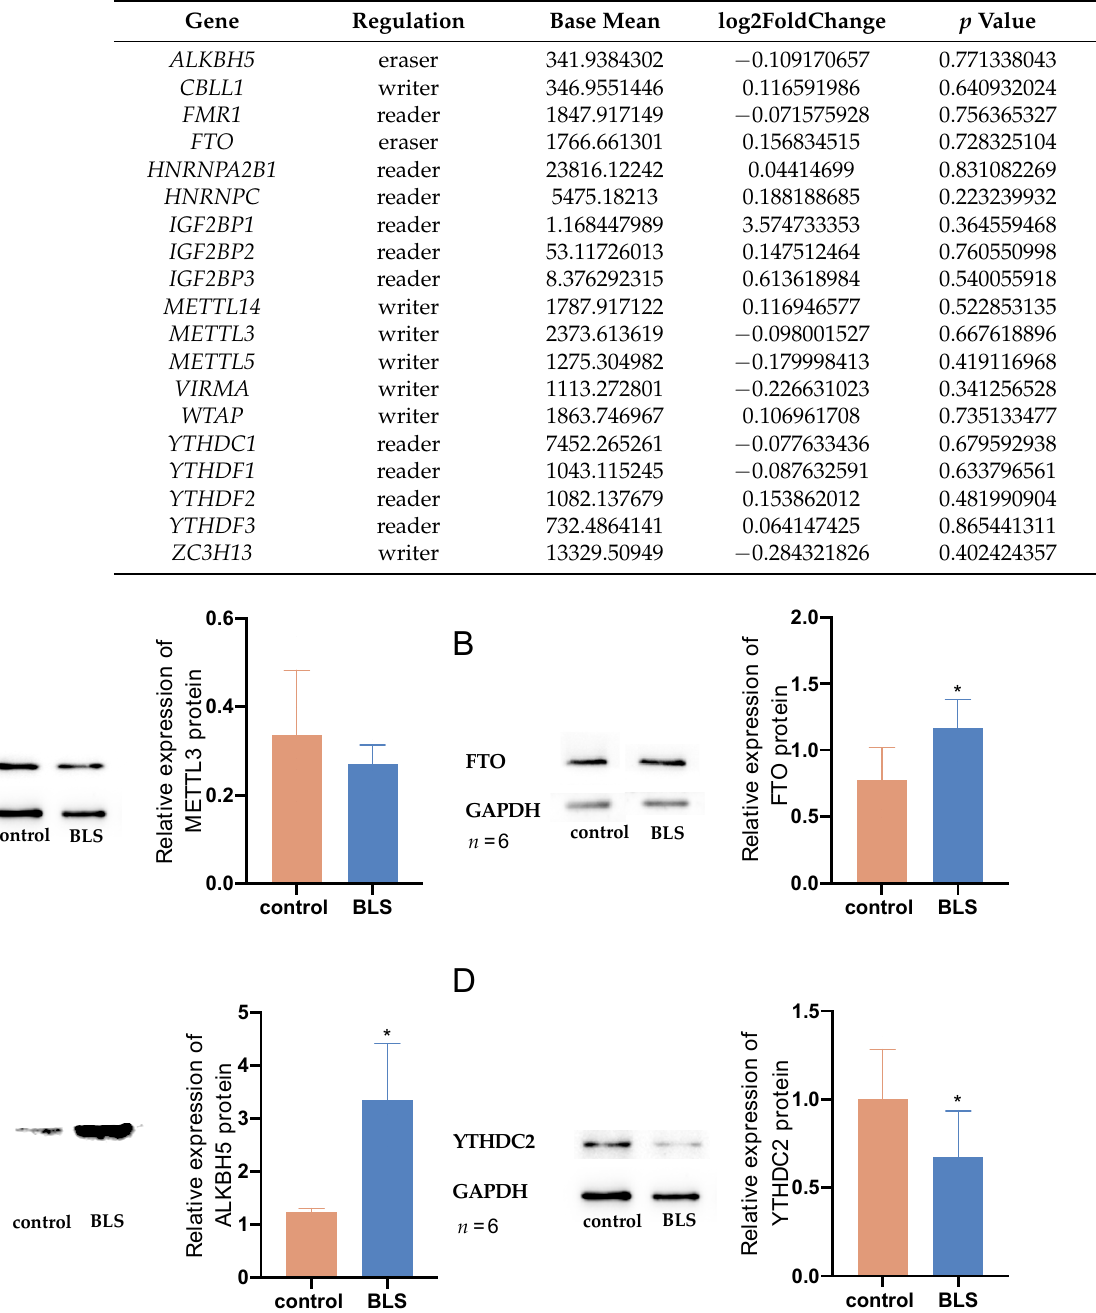
Figure 8. The protein expression level of m6A regulatory factor in LHb. ( A – D ) the protein levels of METTL3, FTO, ALKBH5, and YTHDC2 （ * p < 0.05. ） .